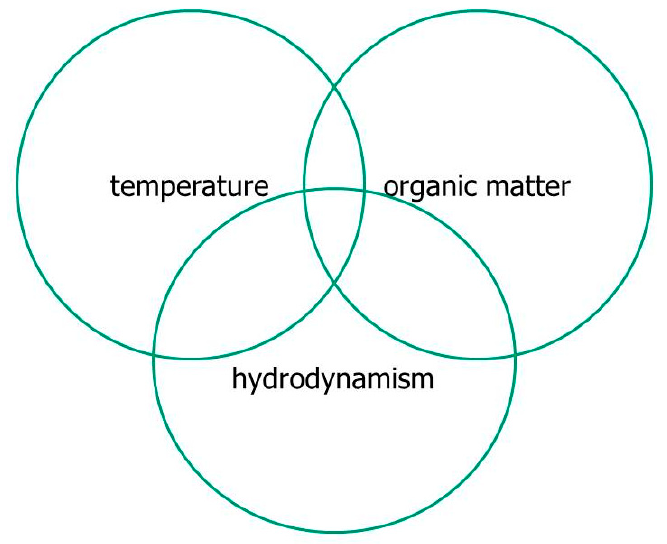
Figure 3. Interaction of the main factors that when combined can determine the onset of a dystrophic phenomenon. From Lenzi et al. [18], modified. phenomenon. From Lenzi et al. [18],